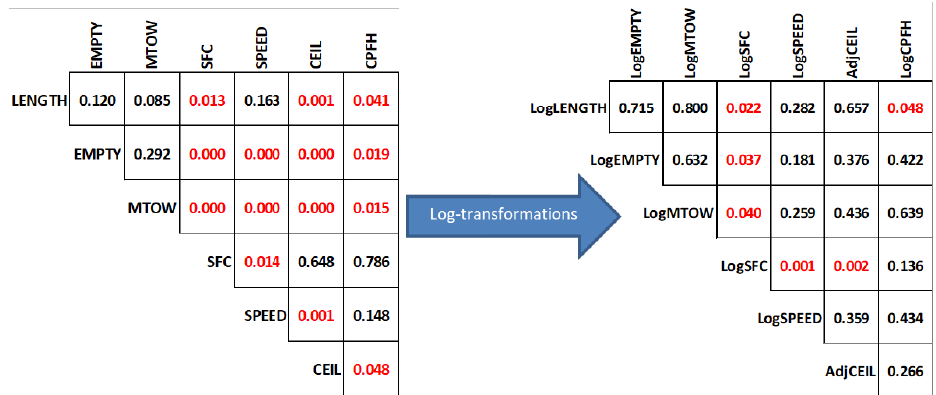
Figure 2. Assessment of the linear model assumptions among the selected variables, using the global test on 4 degrees of freedom. The p -values lower than 0.05 (in red) indicate the rejection of linear model assumptions at the 5% significance level. It is evident that log-transformations enhanced linear relationships among variables.